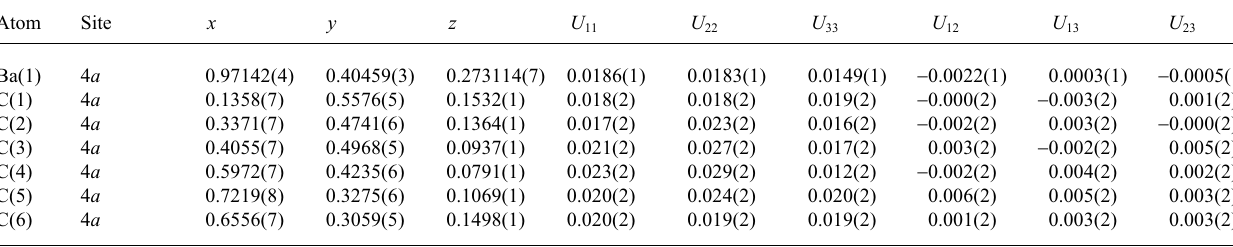
Table 3. Atomic coordinates and displacement parameters (in Å 2